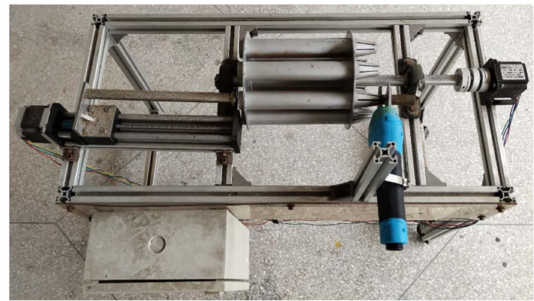
Figure 8. Self-made electric pruning